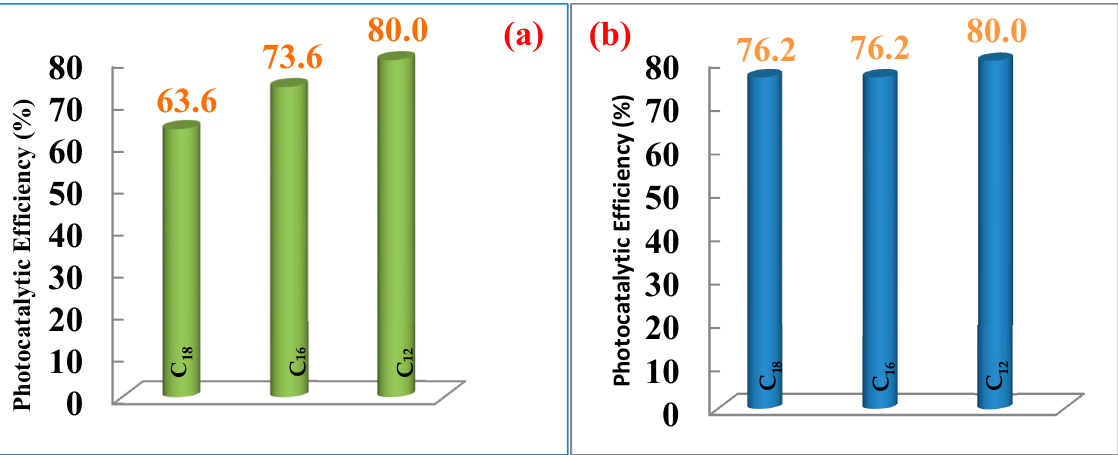
Figure 12. Histograms of degradation efficiencies of MB using copper sulphide nanoparticles at 190 °C versus carbon chain of capping agents using ( a ) complex 1 and ( b ) complex 2.